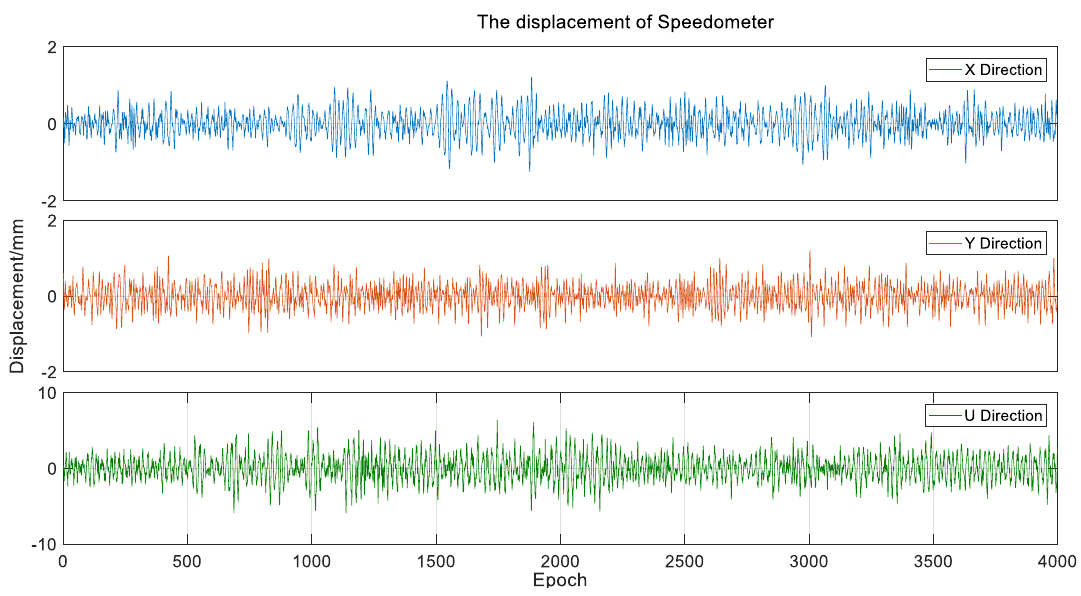
Figure 20. The low-frequency trend decomposed by the VMD and its spectral characteristics.